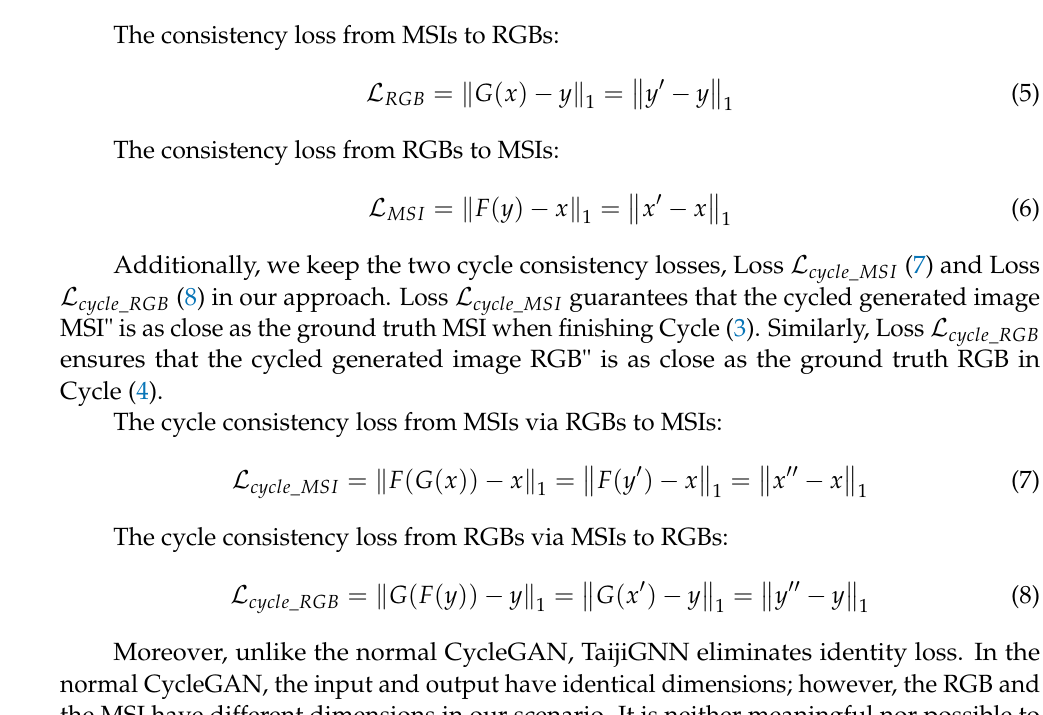
Figure 5. The detailed implementation of